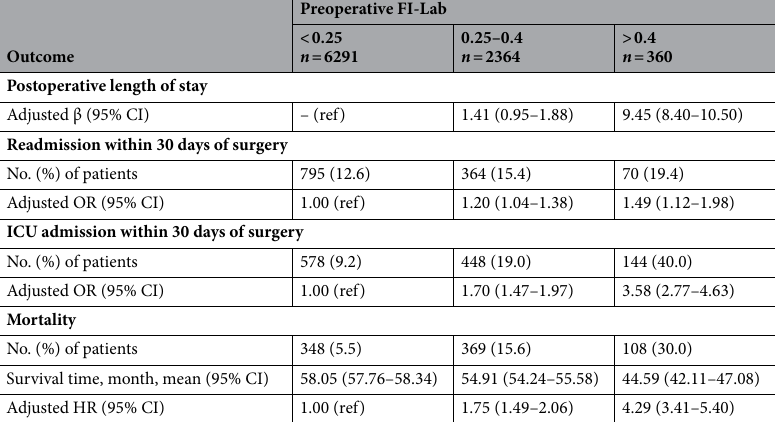
Table 2. Association between preoperative frailty and surgical outcomes. All regression models adjusted for age at surgery, sex, number of comorbidity, operating room duration, and cancer stage. β coefficient after linear regression, OR after logistic regression, mean after Kaplan–Meier method, HR after Cox regression. CI confidence interval, FI-Lab Frailty Index-Laboratory, HR hazard ratio, ICU intensive care unit, OR odds ratio; Ref reference.